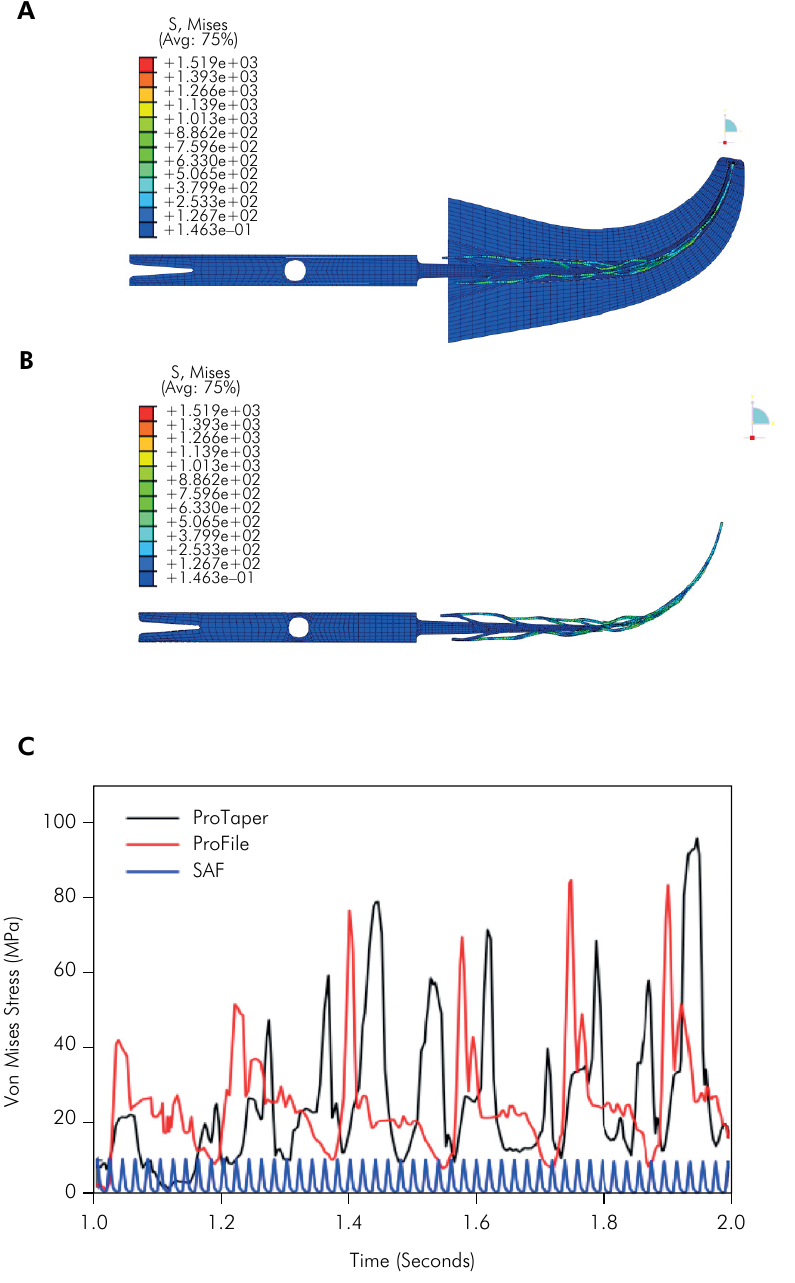
Figure 1. A. Self-Adjusting File (SFA) working in a simulated root canal (Finite element model simulation). B. Final element model of SAF without canal constriction shows the shape adjusted. C. SAF shows lower stress generation comparing with conventional rotary files 53